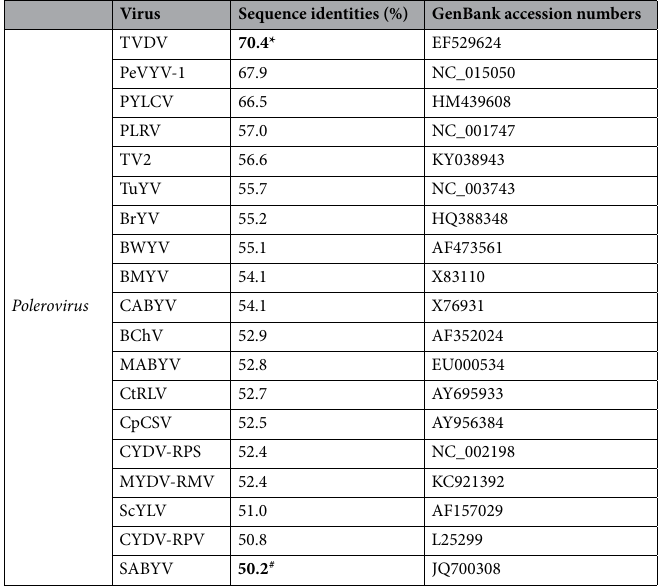
Table 4. Nucleotide sequence comparisons using the near full genomic sequence of TPV2 with that of other poleroviruses . The bold in the table represent the highest and lowest identities individuals. *The virus shares the highest sequence identities with TPV2; # the virus shares the lowest sequence identities with TPV2.